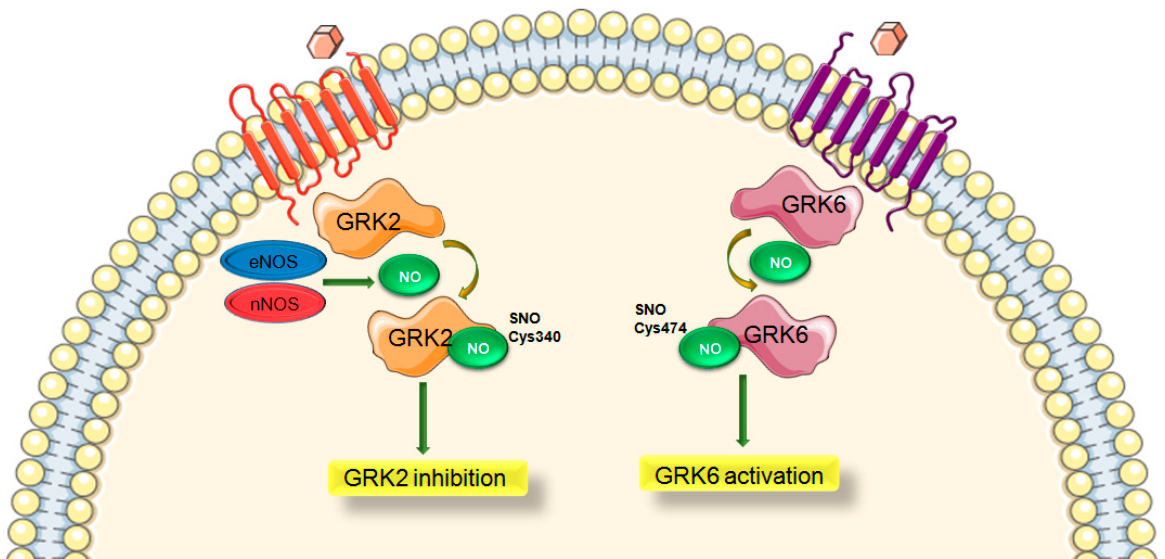
Figure 2. Differential regulation of GRK subtypes via S-nitrosylation. GRK, G protein-coupled receptor kinase; NO, nitric oxide; eNOS, endothelial nitric oxide synthase; nNOS, neuronal nitric oxide synthase. Green arrow is used to indicate a stimulatory mechanism involved.